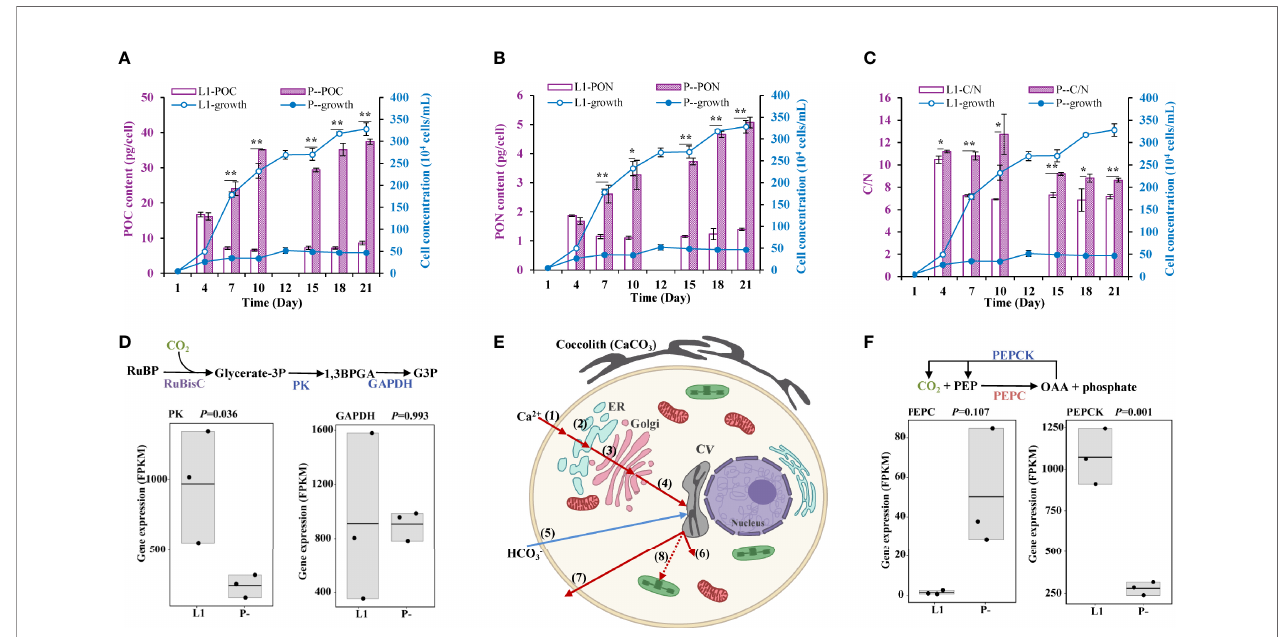
FIGURE 3 | Physiological and the corresponding molecular responses to P-limitation (P-) compared to P-replete condition (L1). (A-C) Cellular particulate organic carbon (POC), organic nitrogen (PON), and C/N ratio in L1 and P- cultures. * indicates p < 0.05 in t -test while ** indicates p < 0.001. Error bars denote ± s.d. of the mean (n = 3). (D) down-regulation of photosynthetic CO 2 fi xation genes (in blue color). (E) Cellular processes of calci fi cation in E. huxleyi and the effects of P limitation. Shown are the up-regulation of Ca 2+ uptake and transport (red-color arrows), down-regulation of HCO − 3 uptake (blue-color arrows), and up-regulation of H + removal (red-color arrows) based on the transcriptomic data. (1) Entry of Ca 2+ into the plasma through Ca 2+ -permeable PM channels; (2-4) Ca 2+ transport across endomembrane compartment, from plasma to ER (2), to Golgi (3), then to CV (4) via Ca 2+ /H + exchanger and supported by Ca 2+ -ATPase; (5) HCO − 3 uptake via HCO − 3 transporter and anion exchanger; (6) H + removal from CV to the cytosol driven by V-type H + transporting ATPase; (7) some H + leaves the cell via voltage-gated H + channel; (8) some H + may be transported to chloroplast to support photosynthesis. (F) Up-regulation of PEPC gene (in red color) for CO 2 incorporation into C4 molecules and down-regulation of PEPCK gene (in blue color) for CO 2